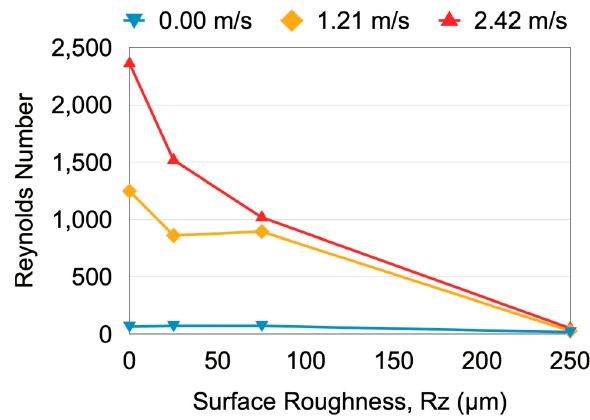
ff erent surface roughness and airflow